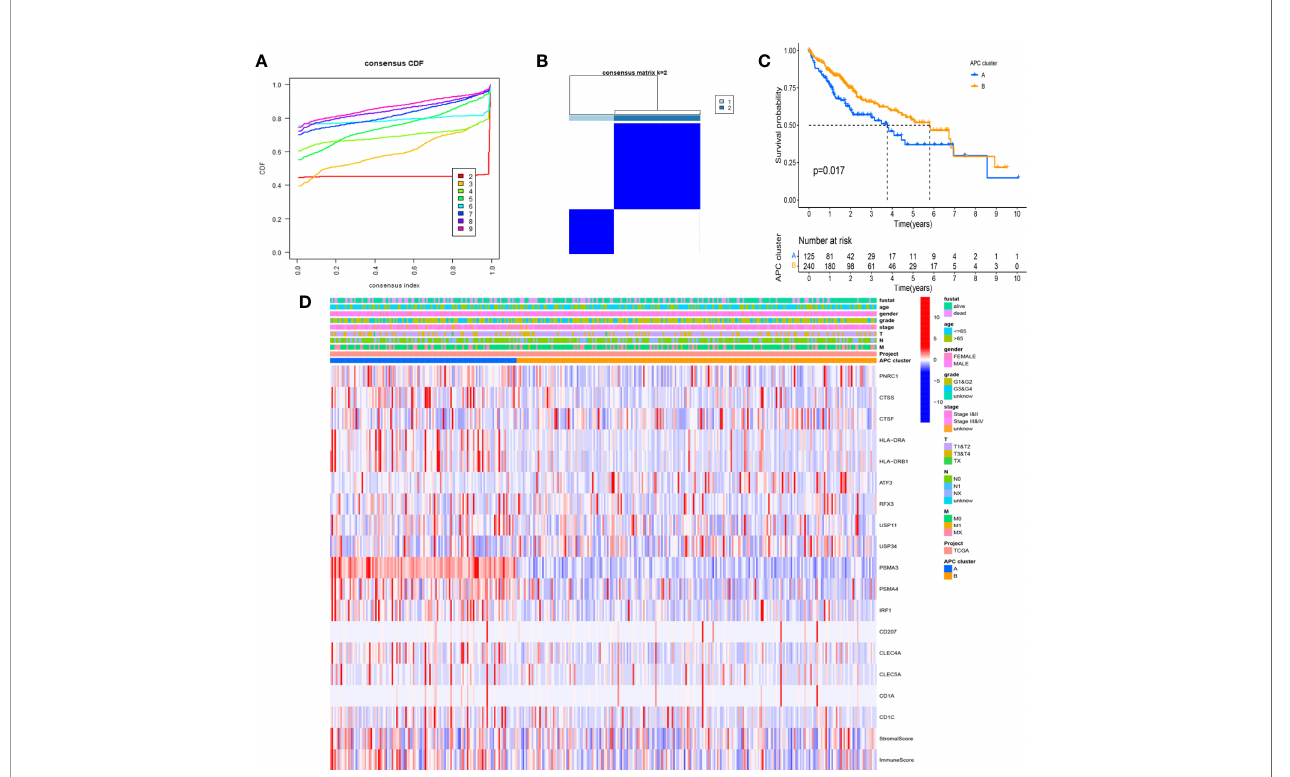
FIGURE 3 | Identi fi cation of main antigen-presenting cell (APC)-related subtypes in hepatocellular carcinoma (HCC). (A) Identi fi cation of the optimal k value in the consensus clustering (k = 2). (B) Expression distribution of different subtypes when consumption index k = 2. (C) The Kaplan – Meier (K-M) survival curve of 2 main APC clusters (p = 0.017). (D) The complex heatmap displays the difference in clinical characteristics and ARG expression levels between different APC